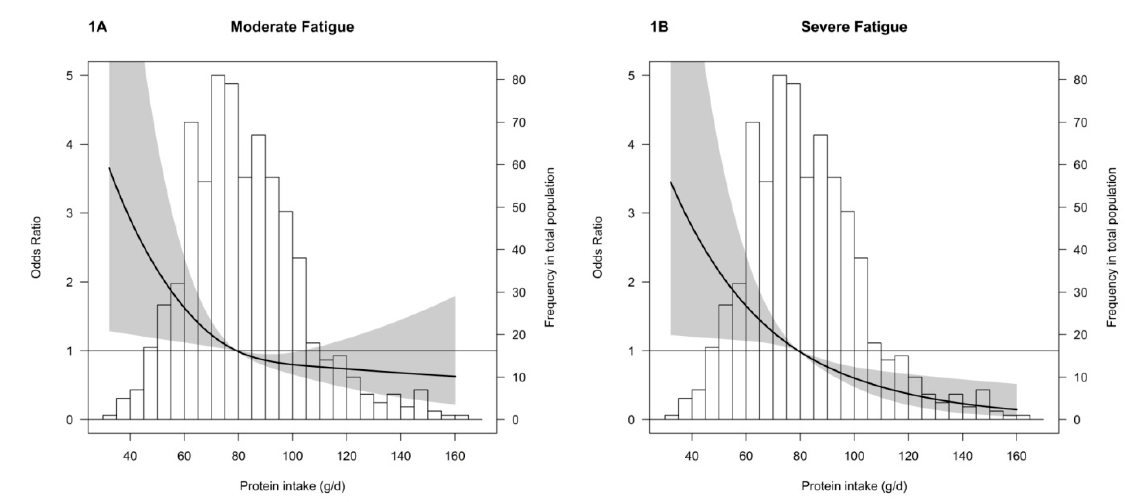
Figure 1. Age-, sex- and BMI-adjusted associations of protein intake with moderate and severe fatigue. Legend Figure 1: Restricted cubic splines showing the association of protein intake (in grams per day) with risk of moderate fatigue ( A ) and severe fatigue ( B ) after adjustment for age, sex and BMI. The black line represents the odds ratio estimate and the grey represent the 95% confidence interval.